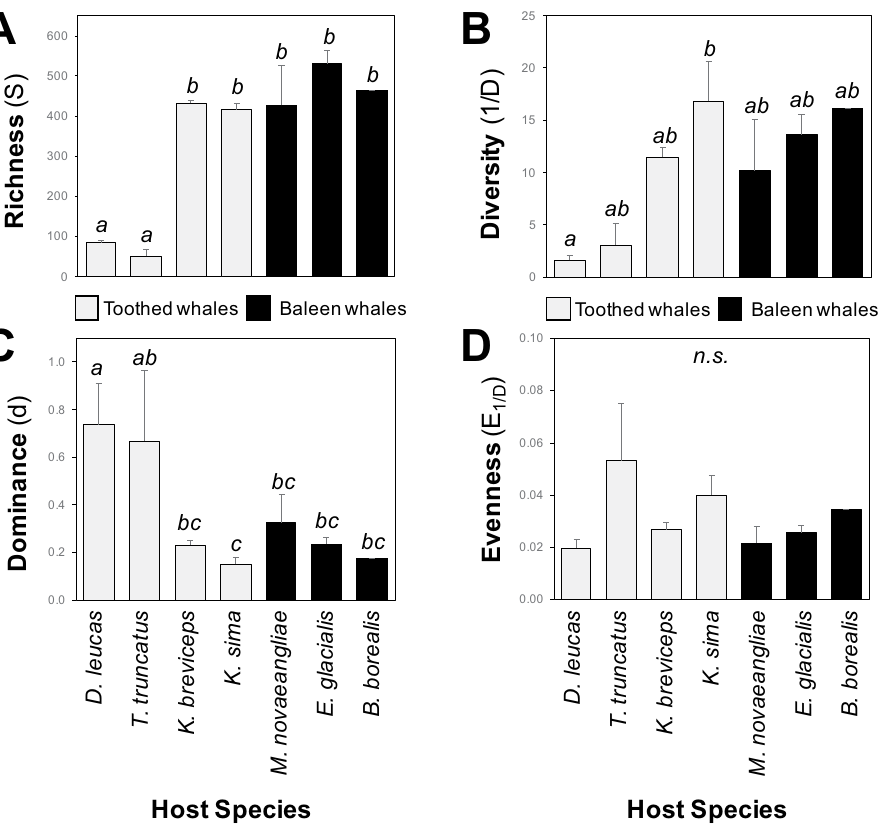
Figure 2. Diversity metrics of kogiid gut microbiomes compared with previous data from other toothed ( gray bars ) and baleen ( black bars ) whales 25 . Different letters above bars denote significantly different means among host species ( P < 0.05). No significant differences in evenness occurred between host species ( n . s . = not significant). Error bars represent ± 1 standard